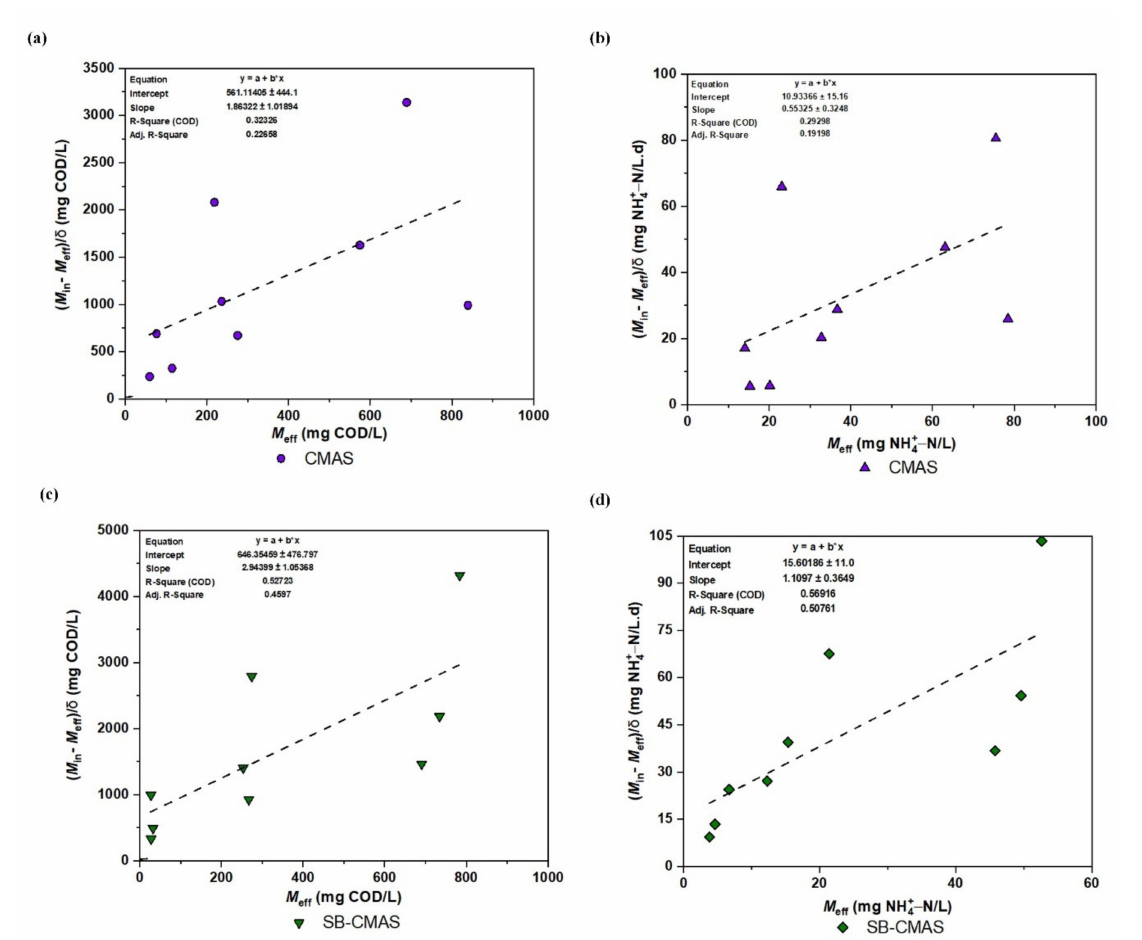
Figure 11. First-order kinetic plot: ( a ) COD for CMAS, ( b ) NH 4+ − N for CMAS, ( c ) COD for SB-CMAS, and ( d ) NH 4+ − N for